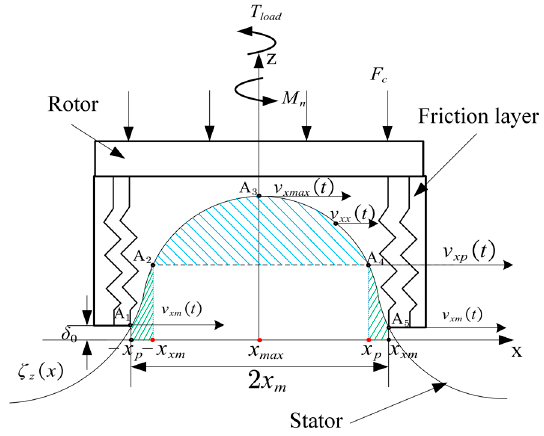
Figure 5. Contact models of the interface between the stator and the rotor. The peak of the wave will penetrate into the friction material, and the contact area is not a point, but a region. At this point, the two resultant forces, the normal force and the tangential force, act on the contact surface. The contact model and transfer model are an- alyzed below.